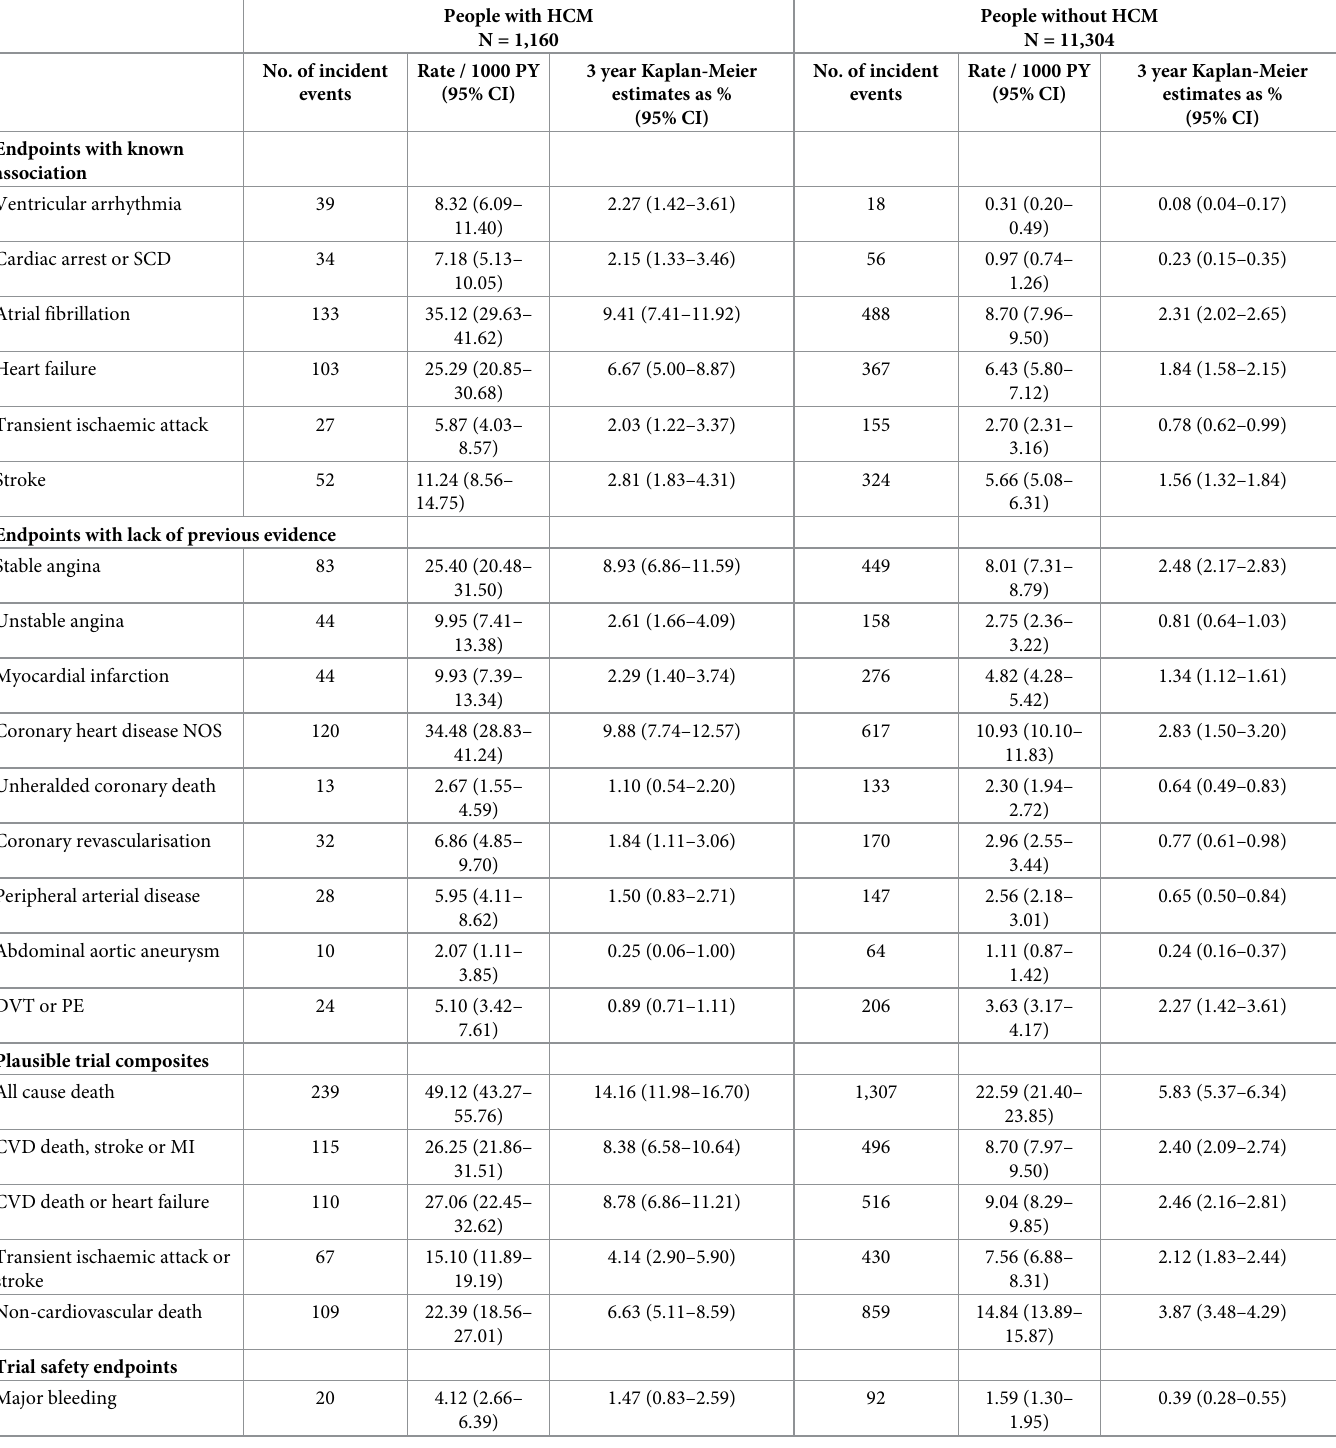
Table 2. Incidence rates of endpoints and 3-year Kaplan-Meier estimates in a national sample of people with and without hypertrophic